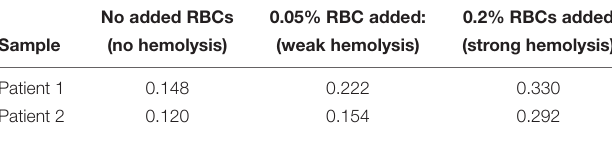
FIGURE 2 | Raw Cq-values of endogenous miR-191-5p, miR-93-5p, miR-30b-5p, and miR20a-5p in serum spiked with hemolyzed RBCs. Values shown are mean Cq-values with SD from the three replicates. Raw Cq-values were adjusted according to UniSp4 in order to correct for variations in RNA extraction